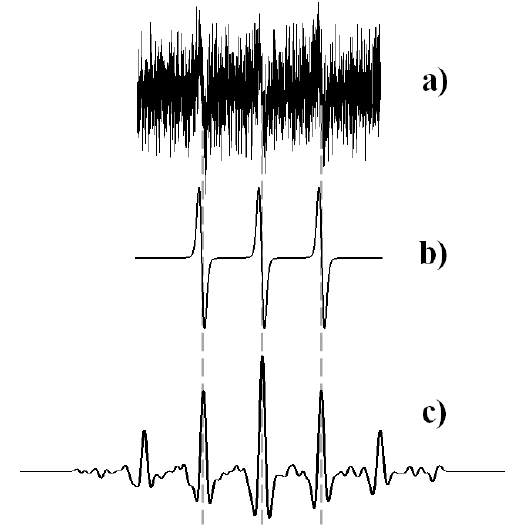
Figure 2. Electron paramagnetic resonance (EPR) spectrum of a liquid probe containing 4-hydroxy-2,2,6,6-tetramethylpiperidine-1-oxide (TEMPOL) ( a ), the spectrum of TEMPOL in PBS ( b ), and the result of their convolution ( c ).